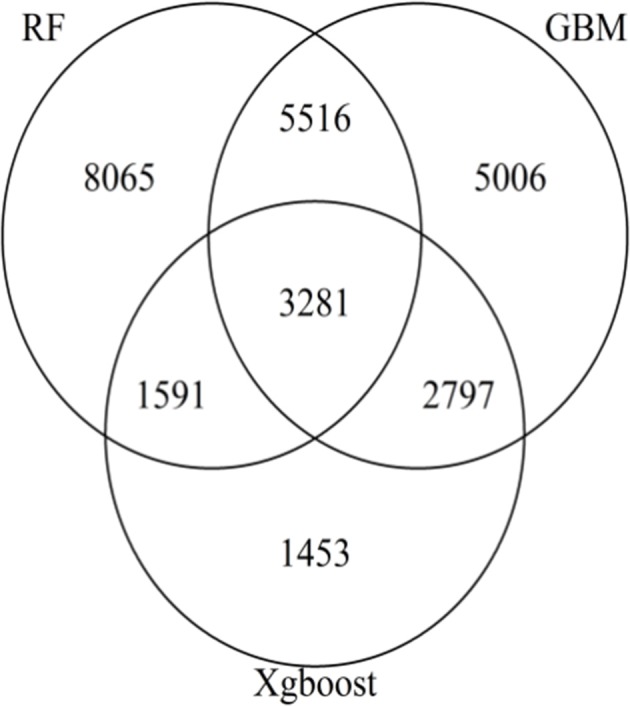
Venn Diagram showing the number of SNPs with non-zero variable importance values for RF, GBM, and XgBoost. Each area of the circle represents the number of SNPs identified by the methods. The areas of intersection of circles represent the number of overlapping SNPs of two or three methods.